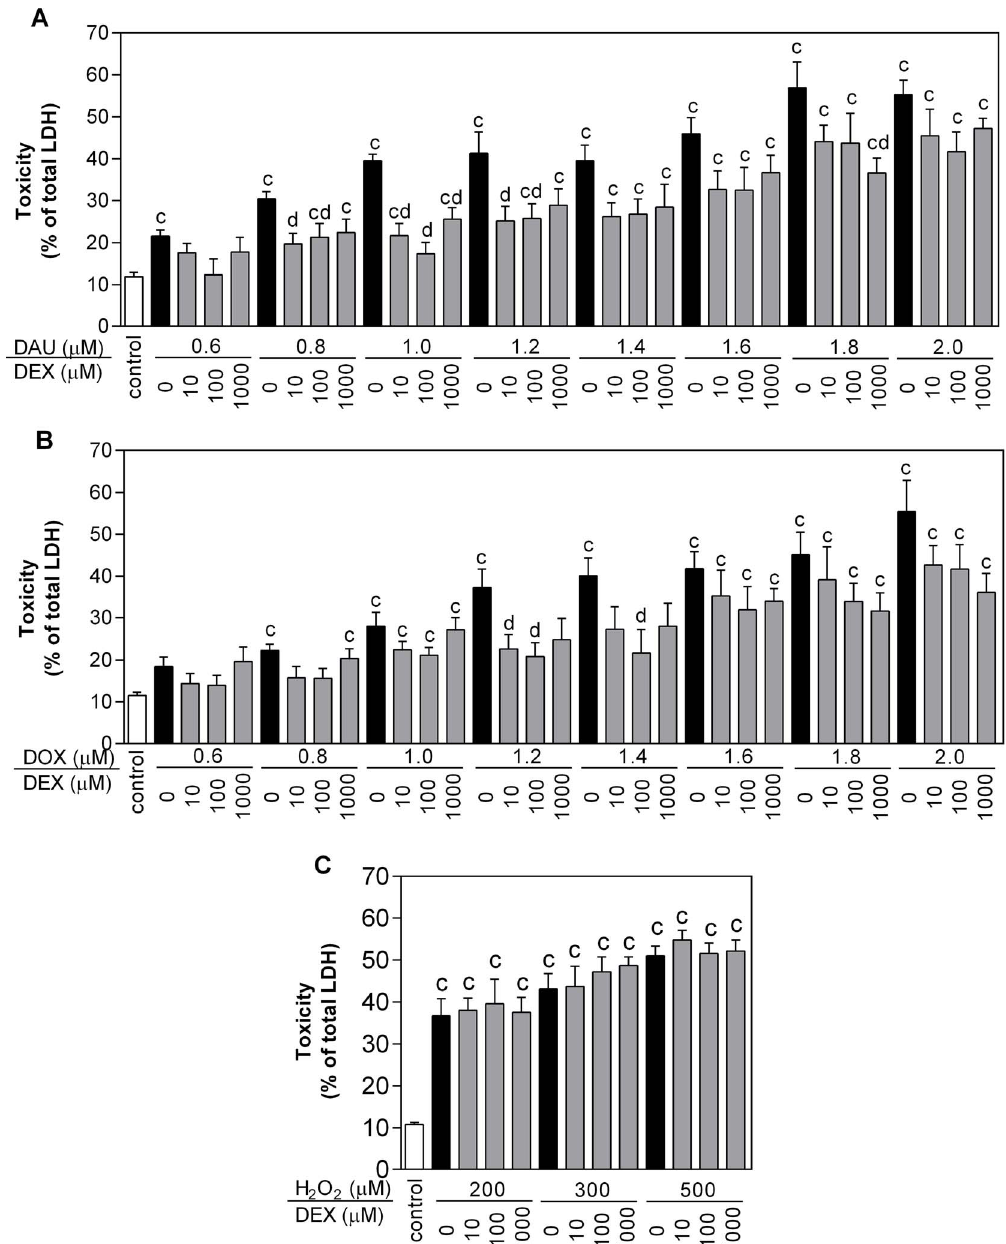
Figure 2. Protection of neonatal rat cardiomyocytes from toxicities induced by anthracyclines and hydrogen peroxide (H 2 O 2 ). Cells were pre-incubated with three concentrations of dexrazoxane for 3 h and then co-incubated with increasing concentrations of anthracyclines daunorubicin (DAU, A) or doxorubicin (DOX, B) for 3 h following a 48-h anthracycline-free period or for 48 h with H 2 O 2 (C). Toxicity was assessed as the % of total lactate dehydrogenase (LDH) released from cardiomyocytes into the cell culture medium. Data obtained from $ 4 independent experiments are expressed as the mean 6 SD, statistical significance: c – compared with drug-free control (DMSO); d – compared with DAU or DOX; p – compared with H 2 O 2 (one-way ANOVA with Dunnett’s post-test, P #